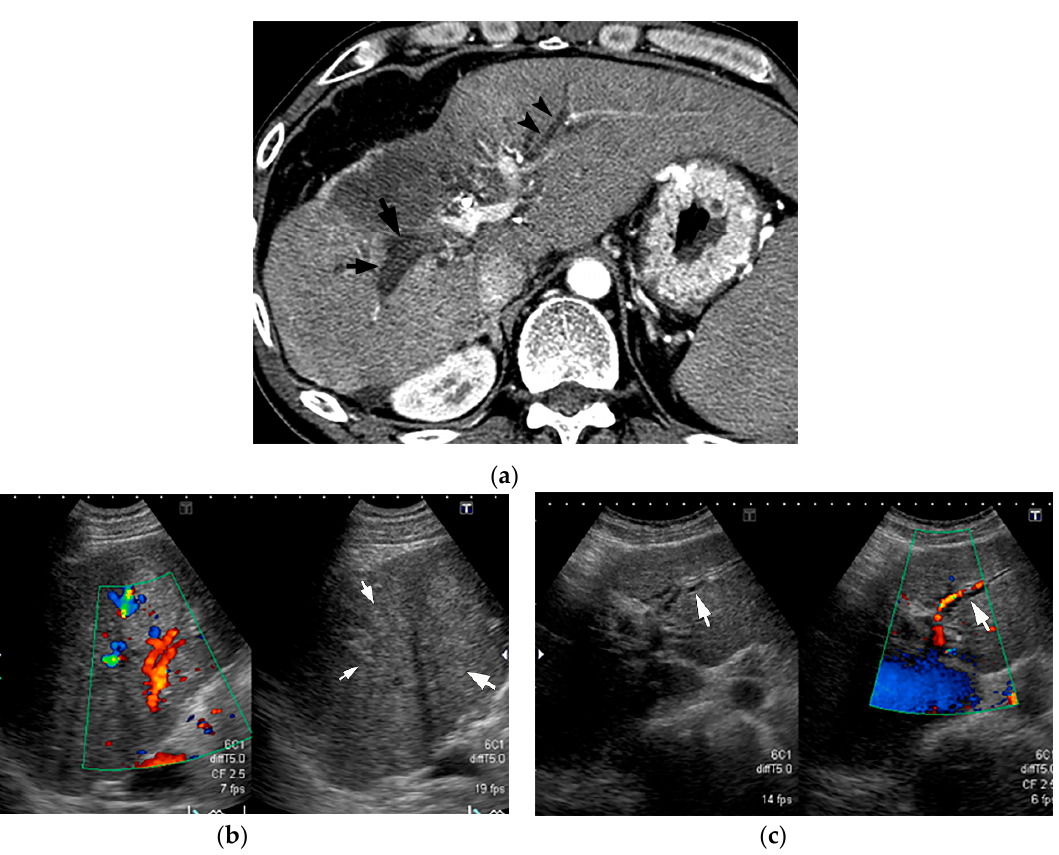
Figure 12. Comparison between CT and ultrasound (US) findings of BDN. ( a ) On contrast-enhanced CT, a hypodense thick tubular structure (arrow) is observed in the hepatic hilum of the right hepatic lobe, and in the left lateral segment, a similar hypodense thin tubular structure (arrowheads) is observed. Although these tubular hypodense structures look like dilated intrahepatic bile ducts, the right lobe lesion is BDN and the left lateral lobe lesion is bile duct dilatation. ( b ) On US images of the right hepatic lobe, no dilated bile ducts are observed in the portal tract. The portal tract shows iso- to slightly hyper-echo compared to the surrounding liver parenchyma (arrows). This US finding is inconsistent with the CT finding. ( c ) In the US image of left lateral lobe of the liver, a slightly dilated echo-free tubular structure (arrows) is observed along the arterial branch, which represents intrahepatic bile duct dilatation. As indicated on Figure 12b, BDN is iso- to slightly hyper-echo compared to the surrounding liver parenchyma and shows discrepancy with the CT